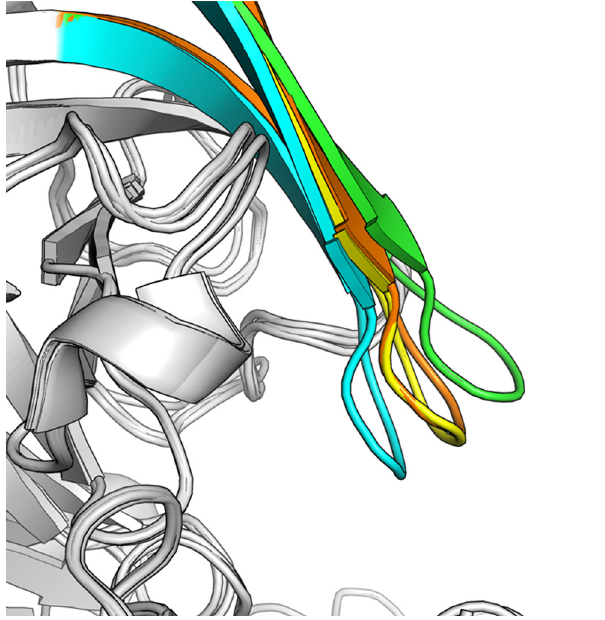
Figure 4. The conformational changes of the flap in BACE1. The superimposition of the X-ray crystal structures of BACE1 represented by pdb code 1FKN (cyan), 1W50 (green), 4IVT (yellow), and 4IVS (brown). The pdb code 4IVT and 4IVS represent the crystal structures of BACE1 complexed with the compounds 19 and 25 ,